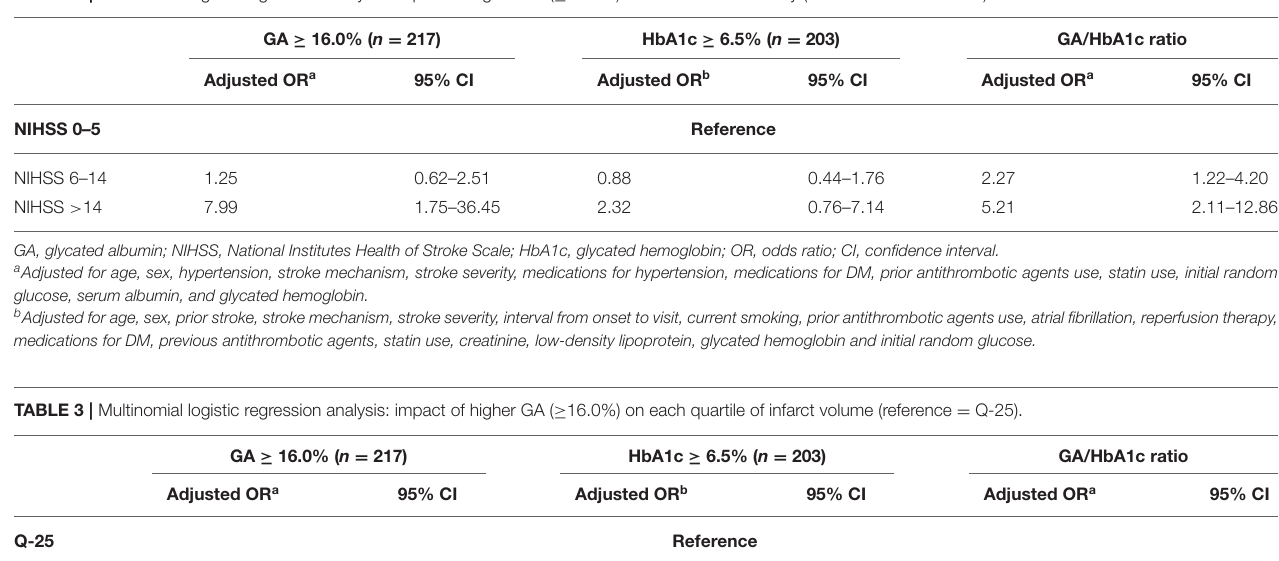
TABLE 2 | Multinomial logistic regression analysis: impact of higher GA ( ≥ 16.0%) on initial stroke severity (reference = NIHSS 0–5).